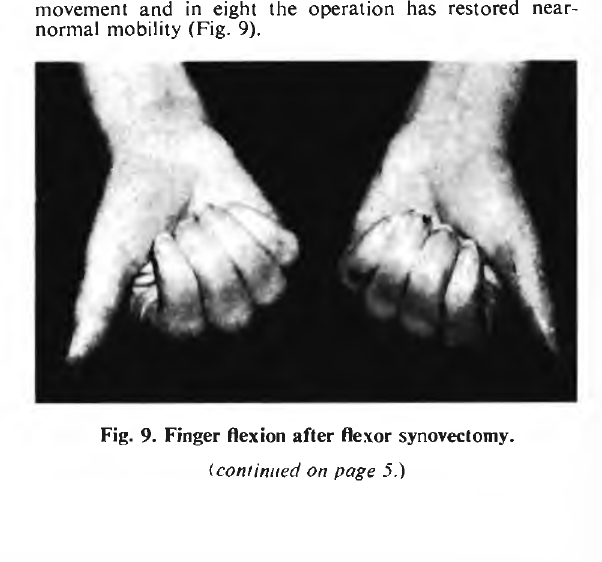
Fig. 9. Finger flexion after flexor synovectomy. (eoniiniied on page